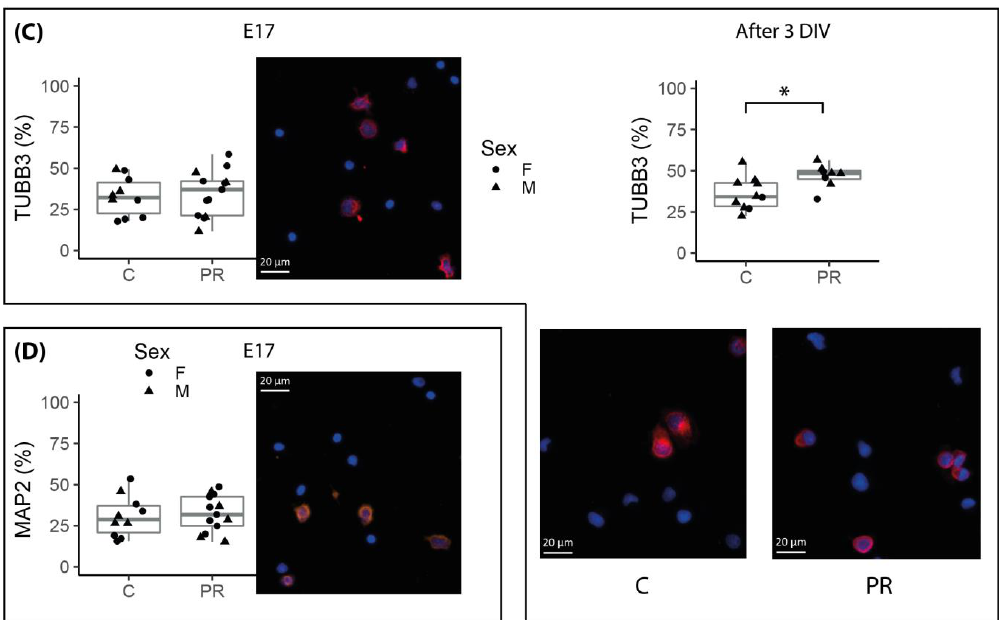
Figure 2. Neural cell type proportions in total hypothalamic cells sampled at E17 and after three days in vitro (3 DIV) labelled by immunocytochemistry and automatically counted on microscopy images. Each marker is illustrated by images obtained by optical microscopy (scale bars, 20 µm). Red and orange labelling is for markers of interest, Ki67 ( A ), Nestin ( B ), TUJ1 = TUBB3 ( C ) and MAP2 ( D ) and nucleus are labelled with DAPI in blue ( n = 6–13 per group). Group and sex effects were tested using two-way ANOVA, *group effect p = 0.02. Non-significant p values are not mentioned. (boxplot: median, first and third quartiles).